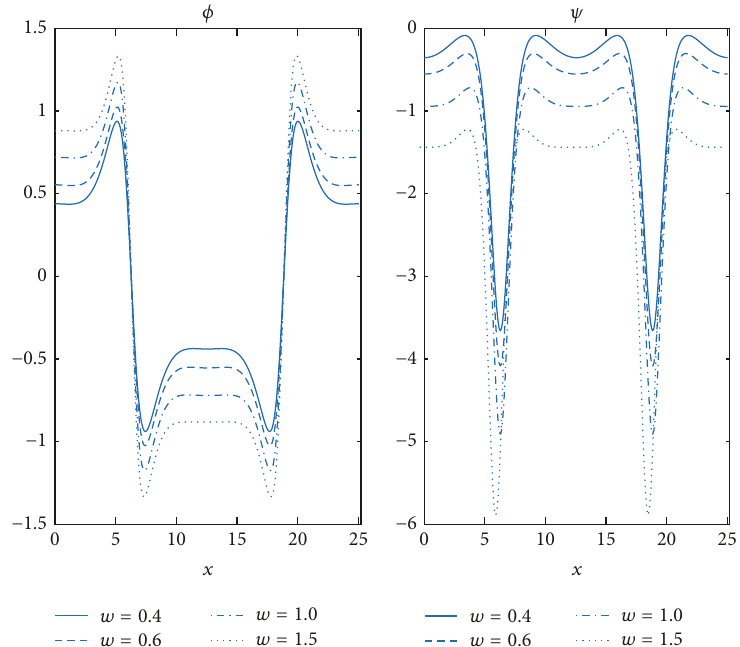
Figure 15: Comparison of periodic travelling wave solutions of the SBO system for different values of the frequency 𝑤 .